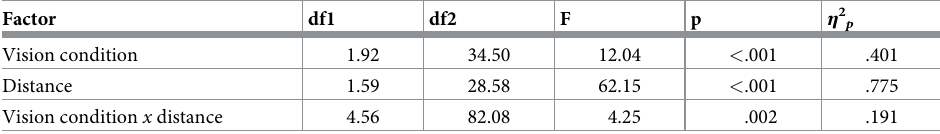
Table 15. Results of the two-factor ANOVA with repeated measures (3 distances; 4 vision conditions) for the pre- dicted putt length. Corrected by Greenhouse-Geisser � . Factor df1